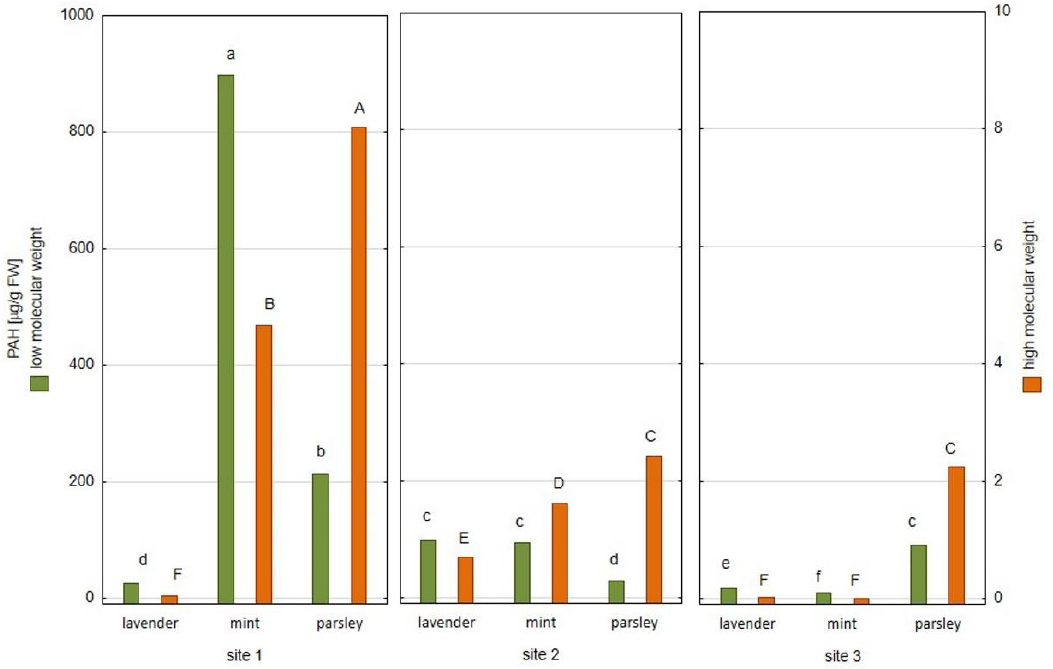
Figure 1. The content of low and high molecular weight PAHs expressed as average ( n = 3) (values denoted with identical letters do not differ significantly at p = 0.05 according to the post-hoc test, following two-way ANOVA for the ‘site × species’ fixed effect; FW—fresh weight).